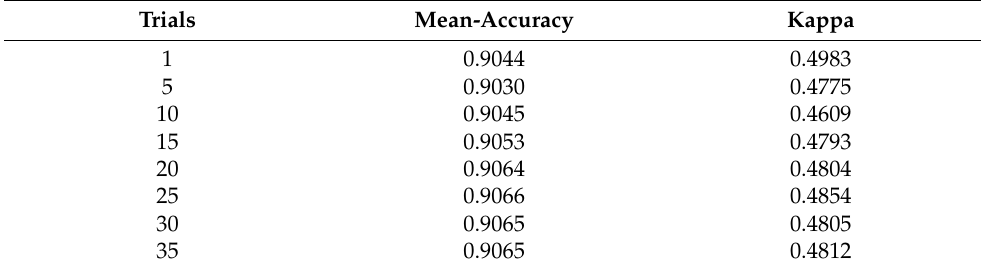
Table 10. Adapted model with